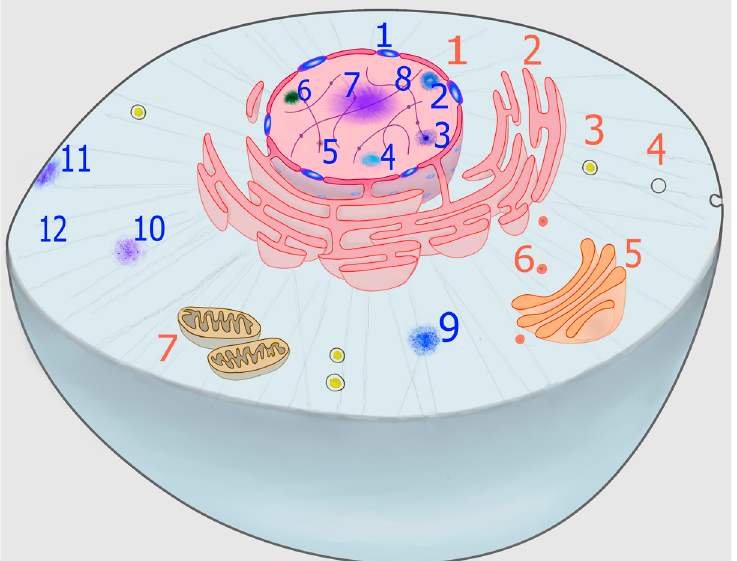
Figure 1. Cellular compartmentalization in eukaryotic cells. The main membranous organelles such as the nucleus (1), endoplasmic reticulum (2), lysosomes (3), endosomes (4), Golgi apparatus (5), vesicles (6), and mitochondria (7) are schematized using warm colors. On the other hand, nuclear MLOs such as nuclear pore (1), nuclear germs (2), PML bodies (3), paraspeckles (4), transcription puffs (5), Cajal bodies (6), nucleolus (7), heterochromatin (8), as well as extranuclear MLOs such as P bodies (9), SGs (10), membrane clusters (11), and cytoskeleton (12) are depicted in cold colors. The list of cellular compartments depicted here is not exhaustive. Some compartments occur only in specific cell types (i.e., synaptic densities and RNA transport granules in neurons; germ granules in germ cells; dicing bodies and photobodies in plant cells; carboxysomes in autotrophic bacteria, or pyrenoids in algae) and they are not shown in the figure.